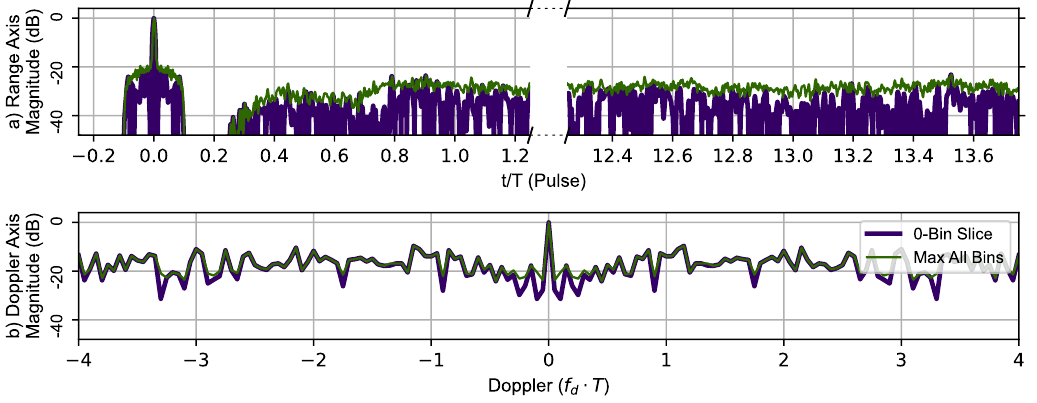
Figure 12. RPL AES-192 method’s 78 pulse ambiguity function cross-sections in peak relative dB scale. ( a ) Top, zero Doppler cross-section (Purple), Max all Doppler cross-sections (Green). ( b ) Bottom, zero delay cross-section (Purple), Max all delay cross-sections (Green). There are no duplicate peaks in the Doppler slice of the ambiguity